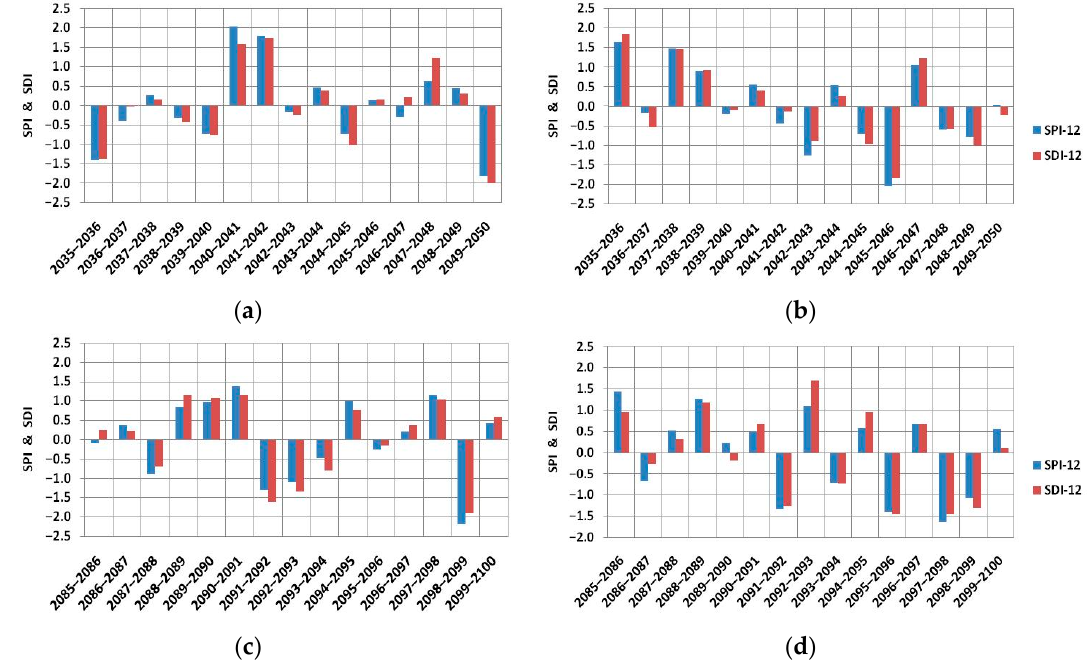
Figure 10. Annual distribution of SPI-12 and SDI-12 ( a ) under RCP4.5, ( b ) under RCP8.5 for the period 2035–2050, ( c ) under RCP4.5, and ( d ) under RCP8.5 within the window 2085–2100.